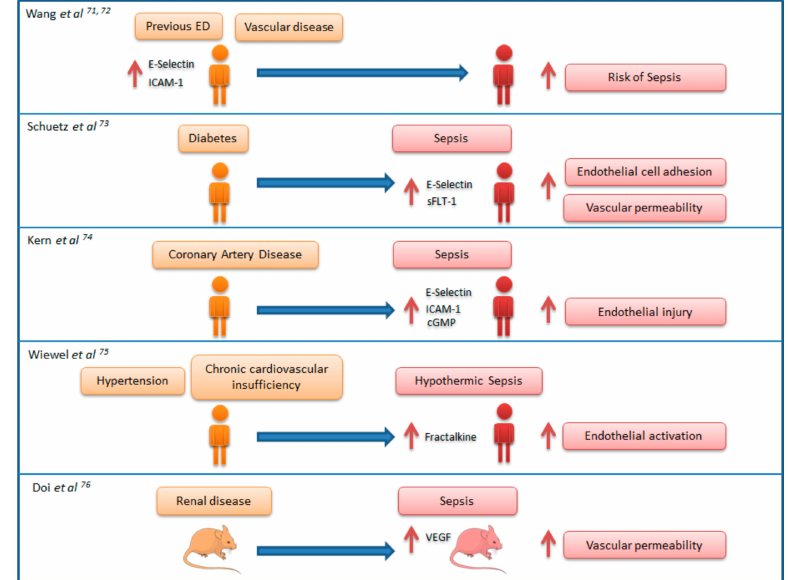
Figure 2. Proof of concept studies supporting the connection between chronic ED and sepsis. Images for representing mice were taken from “Smart Servier Medical Art” (https://smart.servier.com/). ICAM-1: intercellular adhesion molecule 1; VEGF: vascular endothelial growth factor; cGMP: cyclic guanosine monophosphate; sFLT-1: fms-like tyrosine